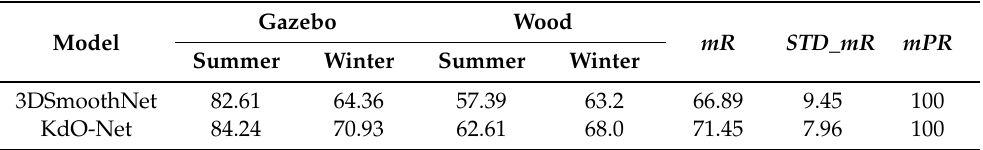
Table 5. Quantitative results on ETH dataset at τ 1 = 10 cm, τ 2 = 5%, and size _ of _ voxel _ grid = 1 m are compared.